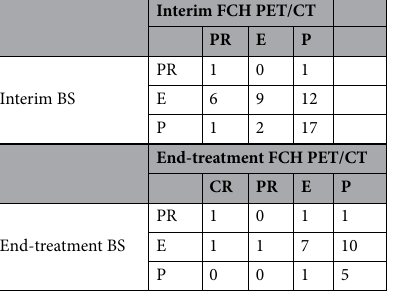
Table 3. Response results of interim and end-treatment bone scan and FCH PET/CT. PR partial response, CR complete response, E stable, P progression, BS bone scan, FCH PET/CT 18F-fluorocholine positron emission tomography/computed